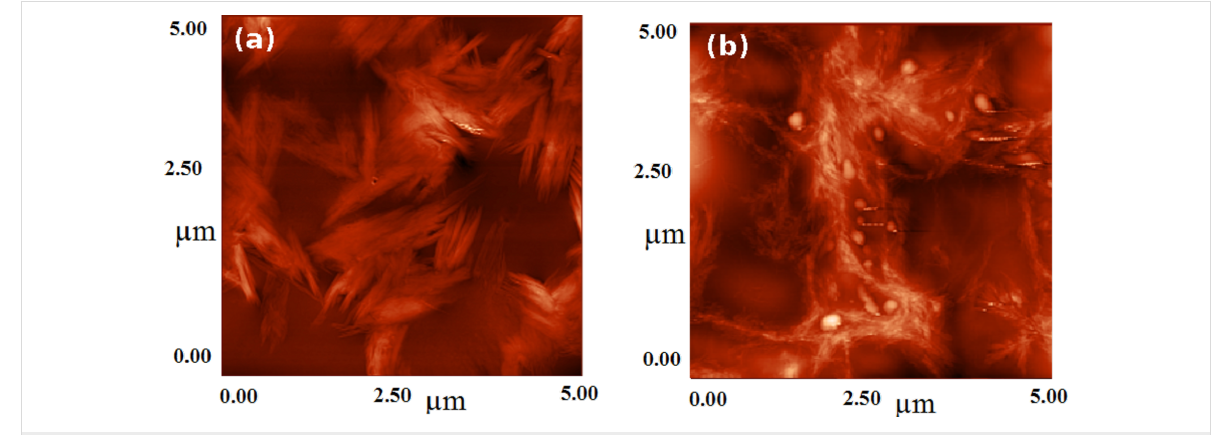
Figure 6: AFM micrographs of nanobioarchitectures without (a) and with (b) cholesterol.